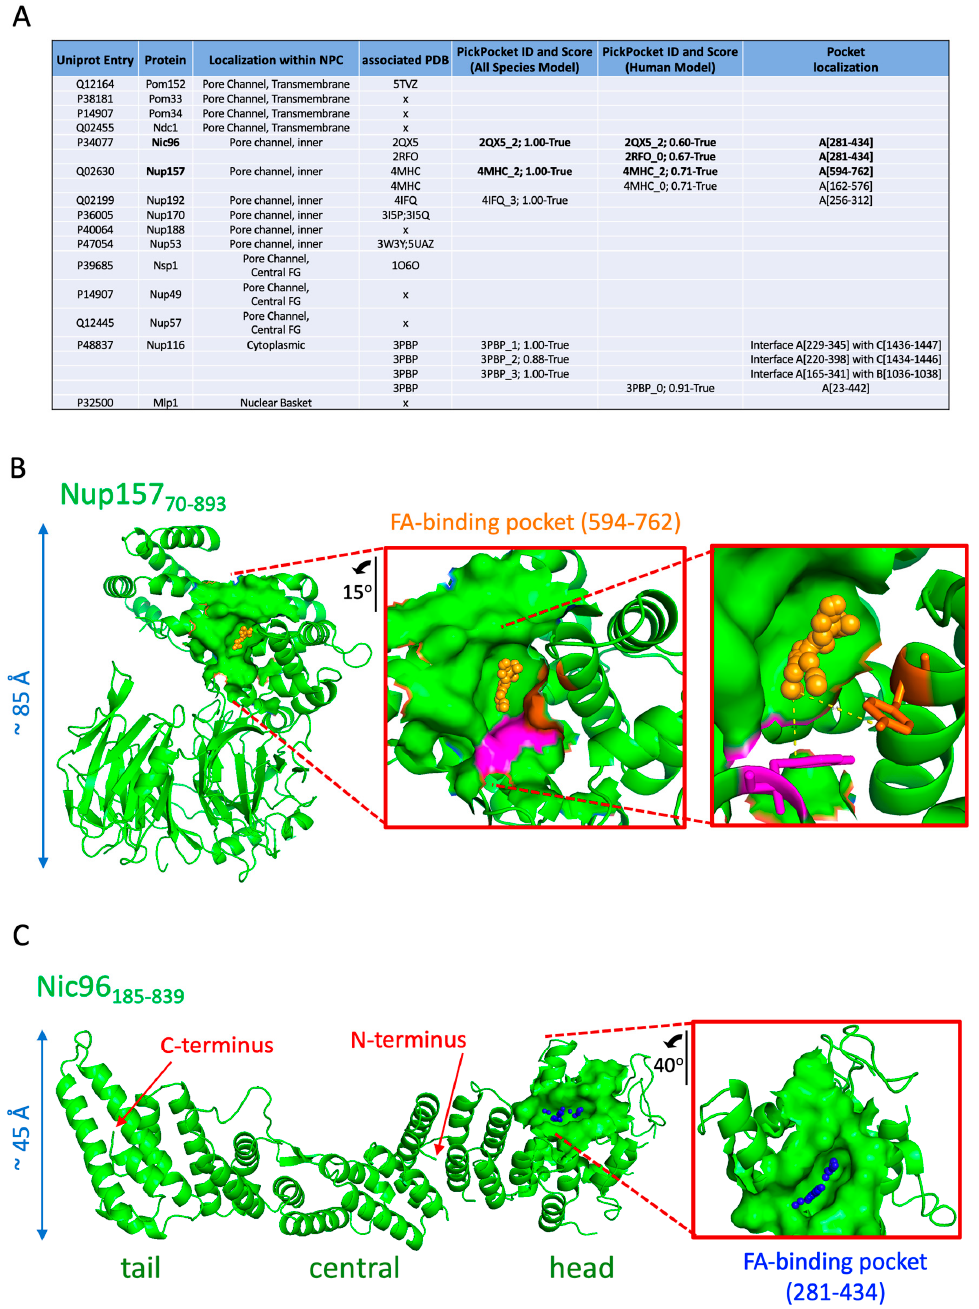
Figure 8. Prediction of fatty acid (FA)-binding pockets in Nups. ( A ) Table compiling the prediction information for all the Nups present on WT LD. Indicated are the presence (or absence, x) of an available PDB ID to be used for the prediction. Only positive results (where “False” is assigned to scores below 0.5, while “True” spans up to the perfect match of 1, see M&M) are indicated upon running PickPocket, which is either trained with an All Species Model or a Human-Only Model. The protein chain and the aminoacids stretch harboring the predicted pocket are also shown. ( B ) Structure of Nup157 (aminoacids 70-893; PDB 4HMC), in which the position and orientation of the predicted FA-binding pocket is highlighted as a filled space. An inset of the coordination of the FA with Tyr594 (magenta) and Tyr646 (orange) is shown. ( C ) Structure of Nic96 (amino acids 185-839; PDB 2QX5), in which the position and orientation of the predicted FA-binding pocket is highlighted as a filled space. The different domains of the protein have been named for clarity.